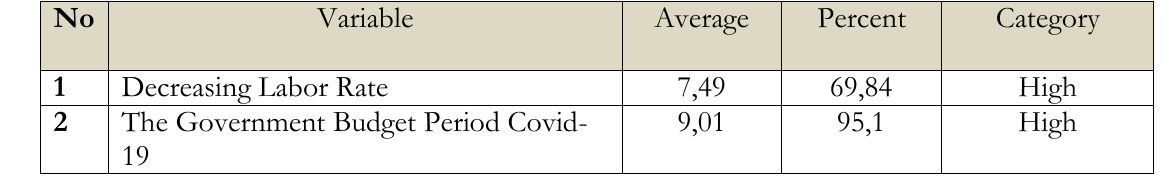
Recapitulation of Research Variable Response